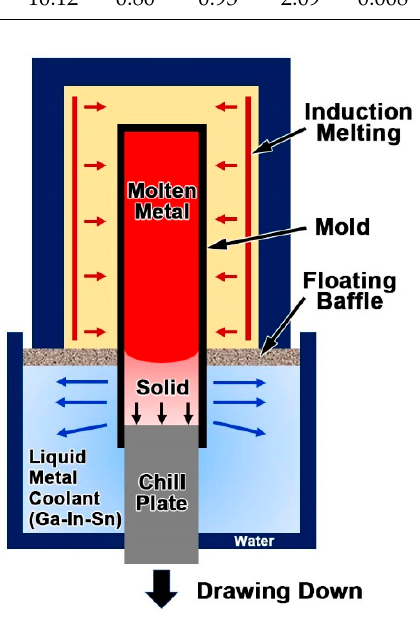
Figure 1. Schematic illustration of the LMC-DS processing [10].